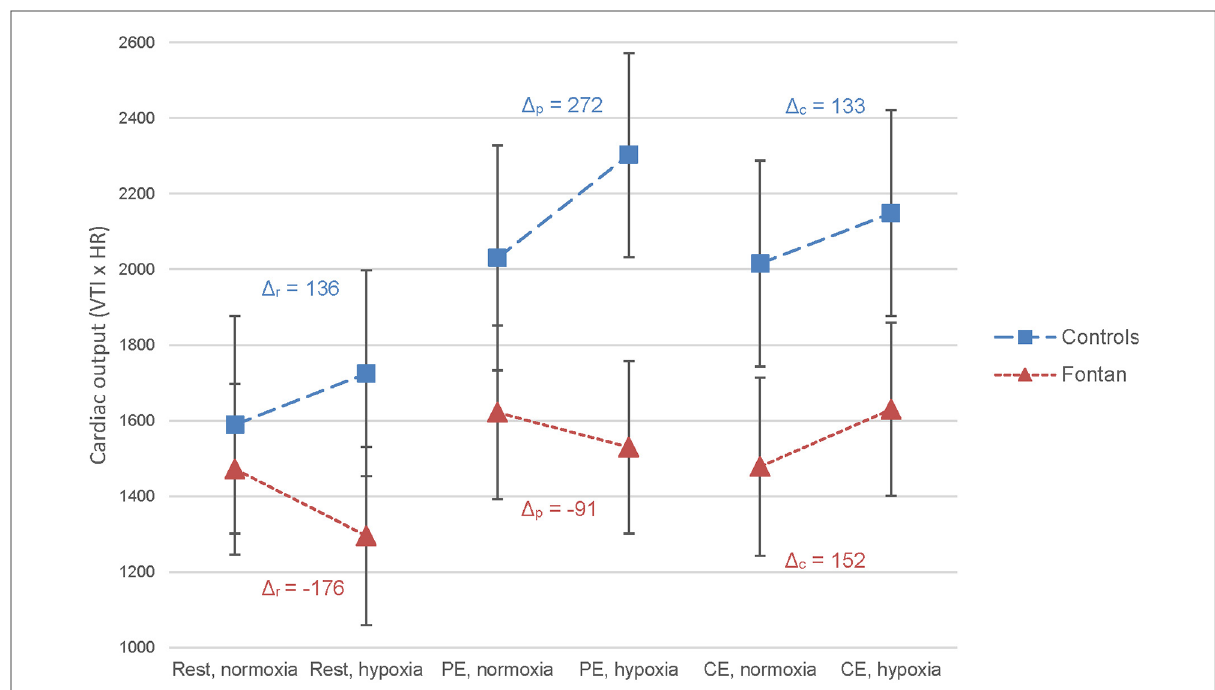
FIGURE 4 Effect of exercise and hypoxia on cardiac output (CO) estimated by velocity time integral×heart rate in Fontan patients and controls analyzed by LMM. A statistically signi fi cant effect of exercise on CO was found in Fontan patients and healthy controls ( p <0.001). Δ =(mean predicted CO in hypoxia – mean predicted CO in normoxia); calculated for each exercise level and